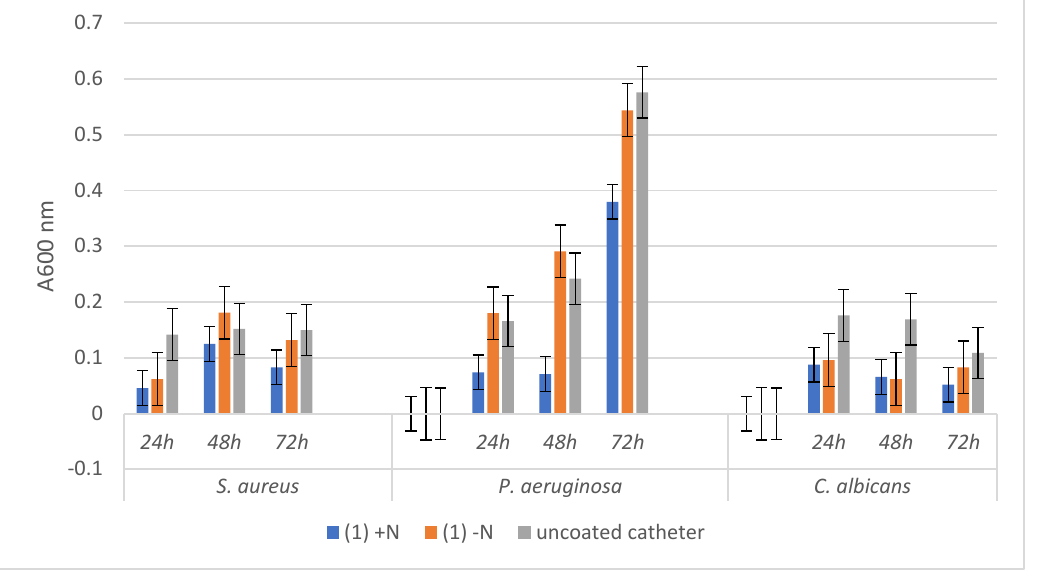
Figure 6. Absorbance values of the three tested microbial strains growth dynamics in the presence of uncoated catheter samples and respectively coated with the hybrid nanostructure (1) + N and the free compound (1) − N.